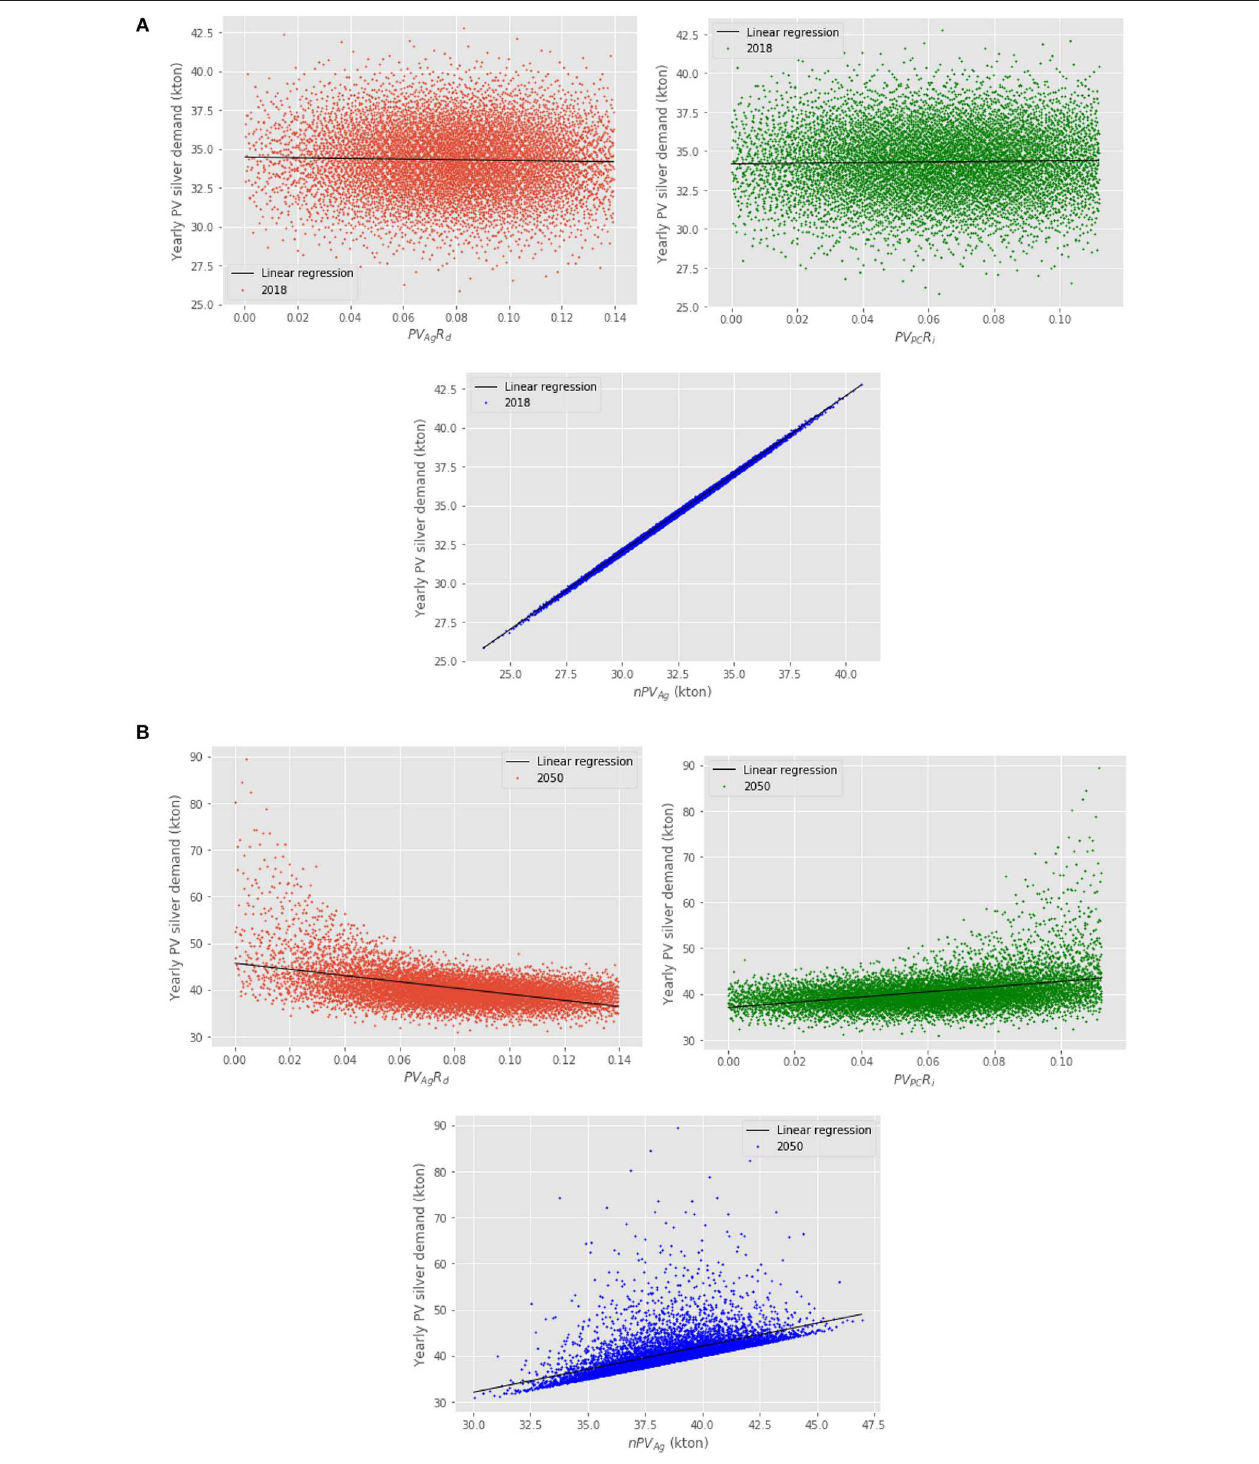
FIGURE 6 | (A) The scatter plots of the Monte Carlo simulations run on 8,192 quasi-random samples. From top-left corner, the yearly silver demand (kton) in the year 2018 is presented against: (i) the decreasing pace of silver use in contact metallization; (ii) the increasing pace of PV modules installation; (iii) the demand from non-PV applications (kton). The line represents the linear fitting of the overall trends. (B) The scatter plots of the 8,192 quasi-random Monte Carlo simulations of the yearly silver demand in the year 2050. The order is the same as per (A) .